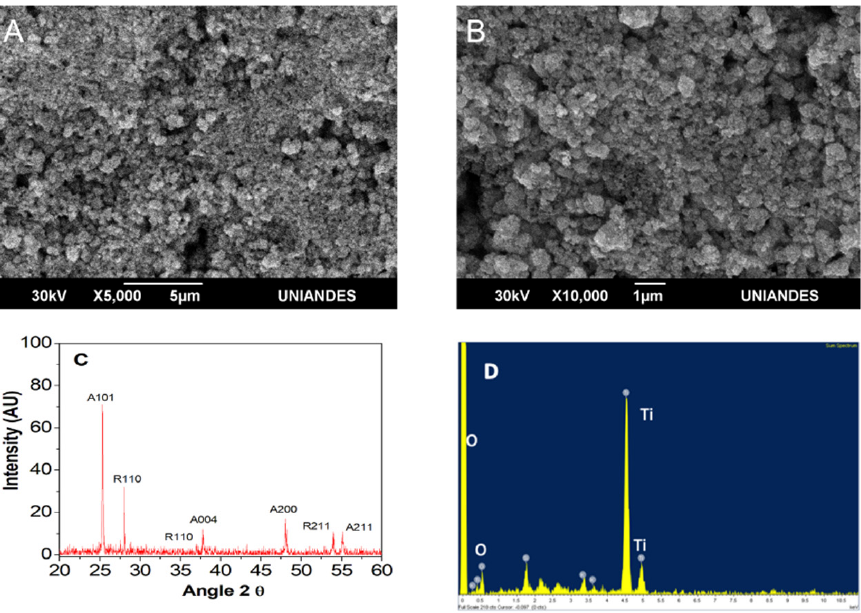
Figure 5. TiO 2 (Aldrich) SEM and XRD analysis. ( A ) TiO 2 (Aldrich) SEM images at 5000× TiO 2 (Al- (Aldrich). ( B ) SEM at 10,000 × . ( C ) EDS analysis. ( D ) XRD drich). ( B ) SEM at 10,000×. ( C ) EDS analysis. ( D ) XRD results.